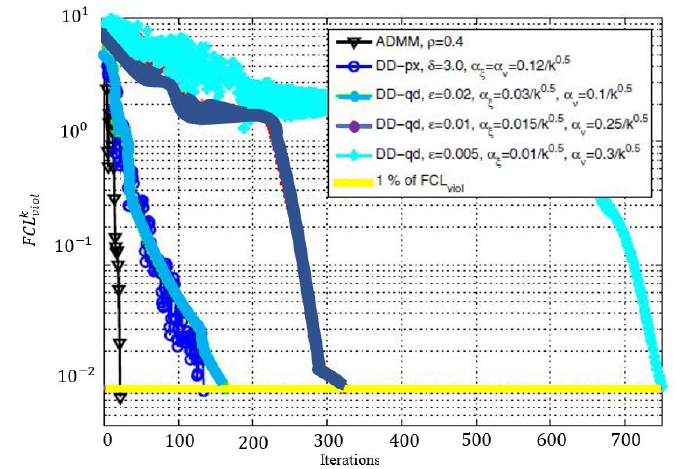
Figure 15. Convergence of the ADMM consensus scheme versus the dual decomposition scheme represented by the flow conservation constraint violation